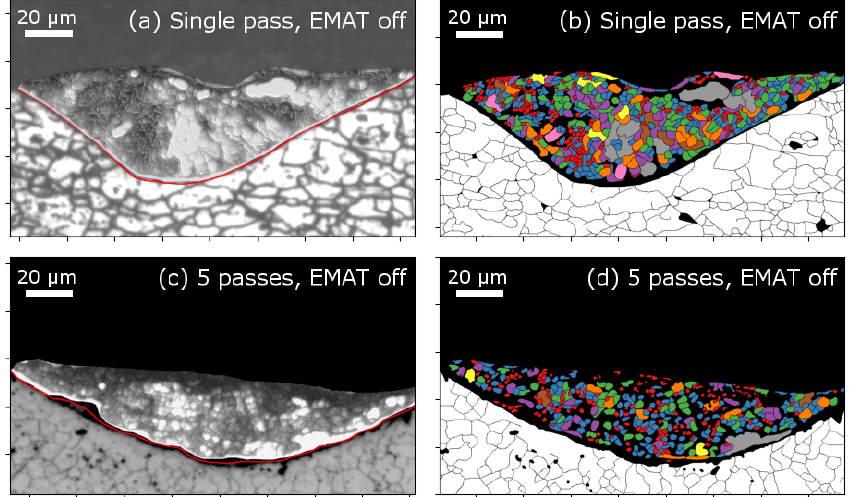
Figure 3. Metallographic images of microstructure of the AISI 321H stainless steel plate after pulsed laser exposure with EMAT turned off: ( a ) single laser pass and ( c ) five laser remelting passes. For the purpose of statistical analysis, the micrographs are computationally segmented and the grains are colored according to their size in ( b , d ) correspondingly. The same colors are used in Figure 5 (at the top of each histogram) in order to quantify the grain size intervals.